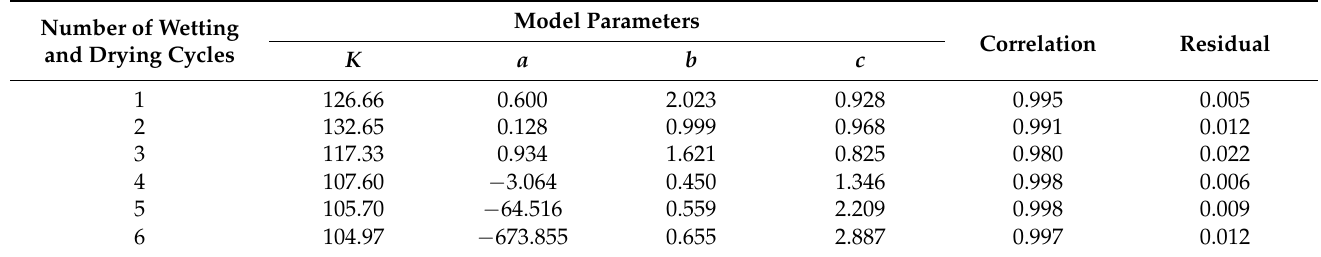
Table 1. Richards model parameters (cumulative sediment loss value ( K ), the initial sediment loss value ( a ), the rate of change ( b ), and the allometric parameter ( c )) used for predicting the soil detachment rate as affected by wet-dry cycles and their corresponding correlation and residual values.